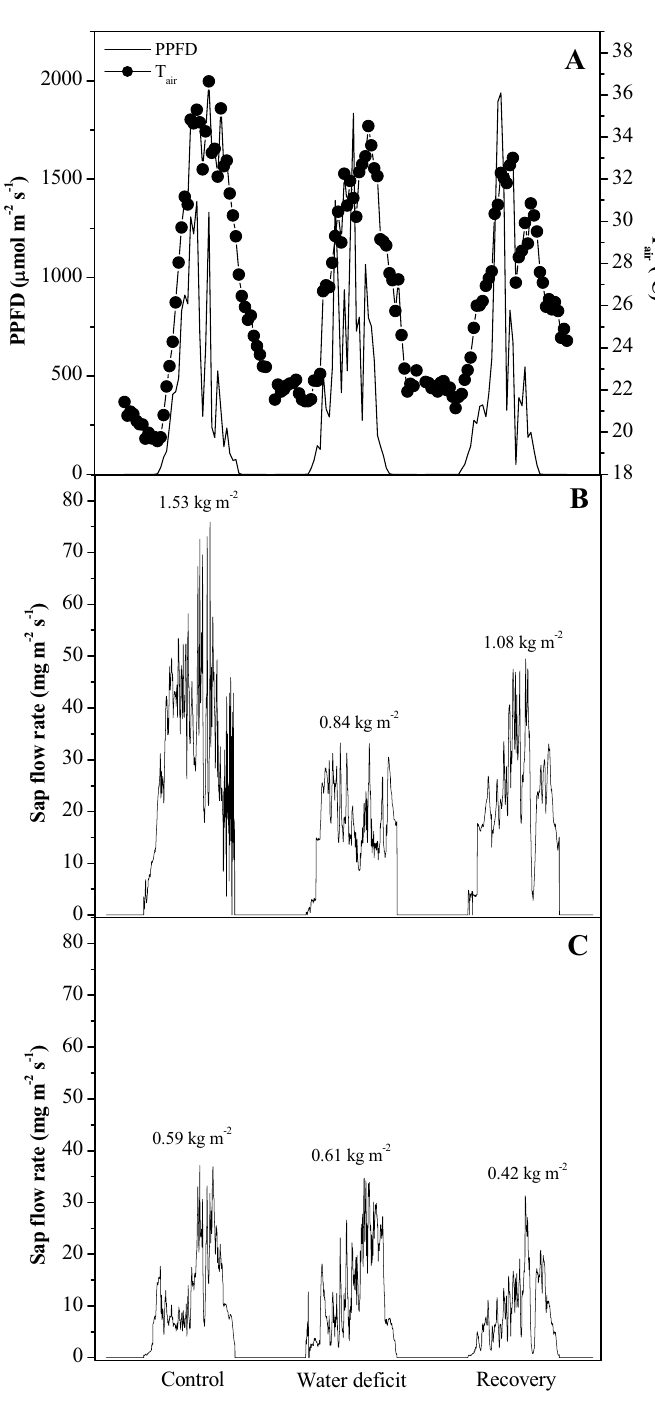
Fig. 1 – Daily changes in photosynthetic photon flux density (PPFD) and air temperature (Tair) (A), and mean sap flow of three seedlings of G. ulmifolia (B) and C. legalis (C) at each experimental condition: control, water deficit, and recovery. Values of daily-integrated sap flow (kg m –2 ) are shown for each condition.